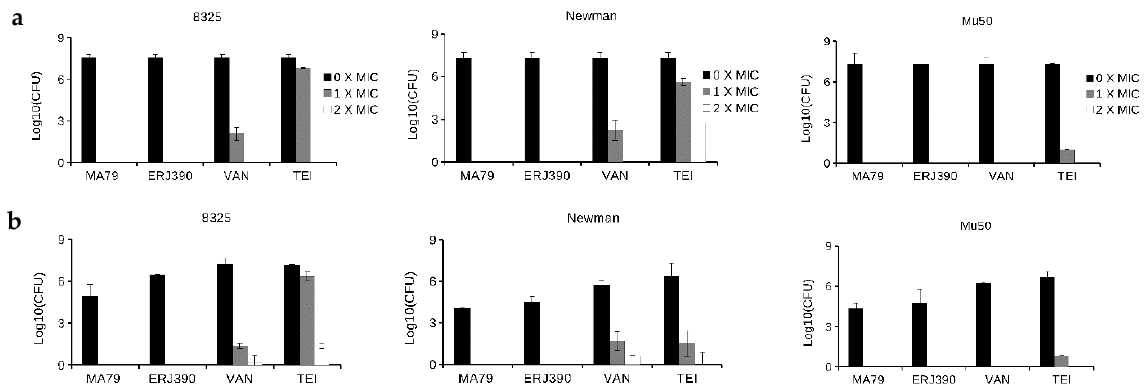
Figure 7. Selection of S. aureus 8325, Newman, and Mu50 resistant mutants, with ( a ) or without ( b ) prior incubation with subinhibitory concentration of antibiotics. The graphs show the number of colonies that appeared on the BHI agar plates with the respective antibiotic at 0-fold, 1-fold, or 2-fold MIC.